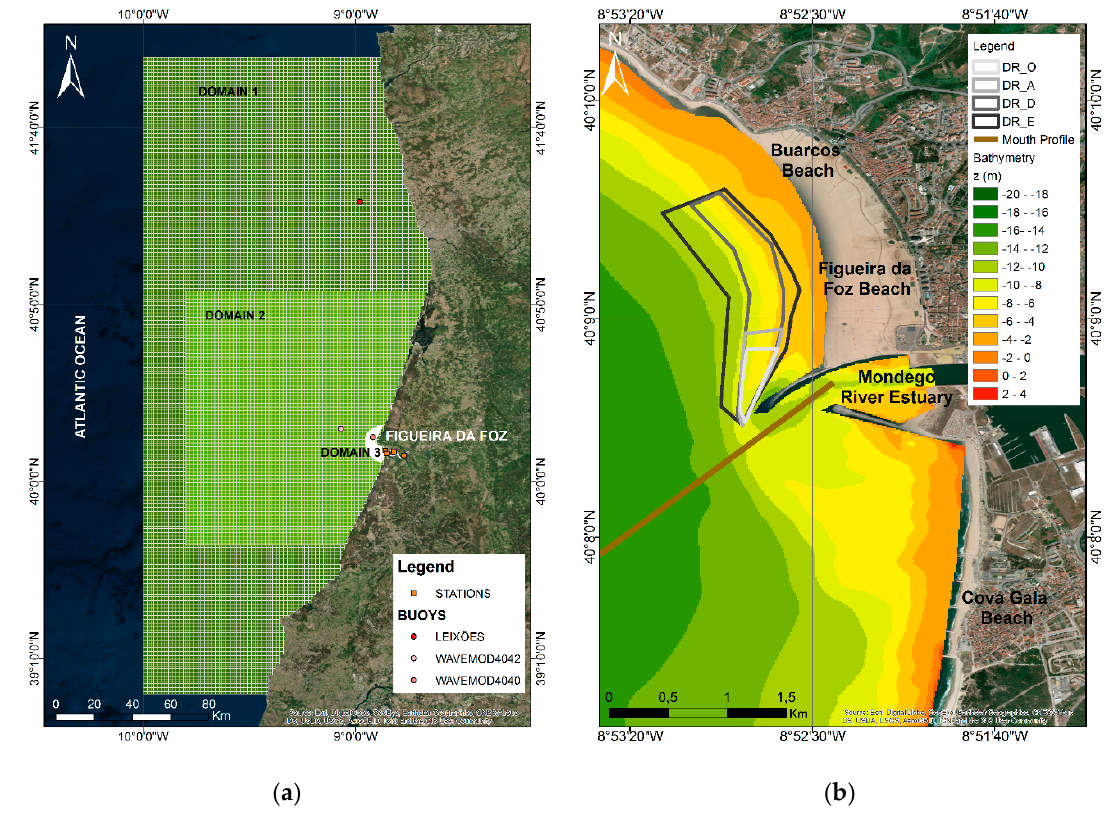
Figure 2. ( a ) Numerical grids: domain 1, domain 2, and domain 3 including position of buoys and stations whose data were used to validate model; ( b ) reference numerical bathymetry (domain 3: Figueira da Foz—Cova Gala) including polygons of dredging scenarios.